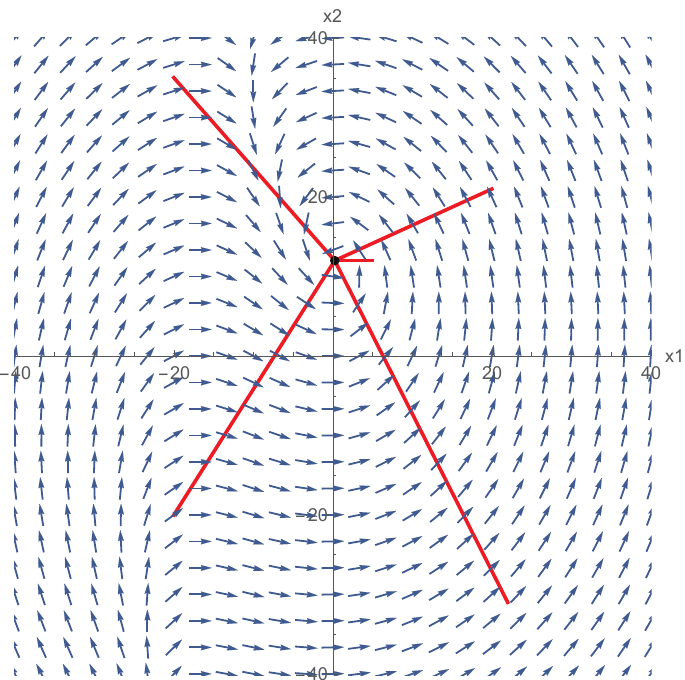
Figure 8. The phase portrait of closed-loop system. The black point is the equilibrium. The red lines are the state